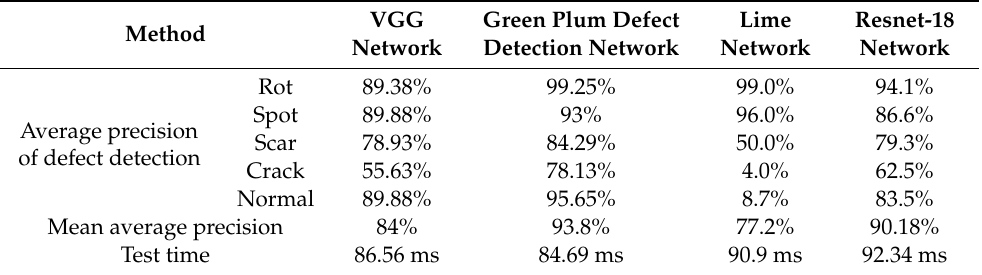
Table 4. Green plum defect detection